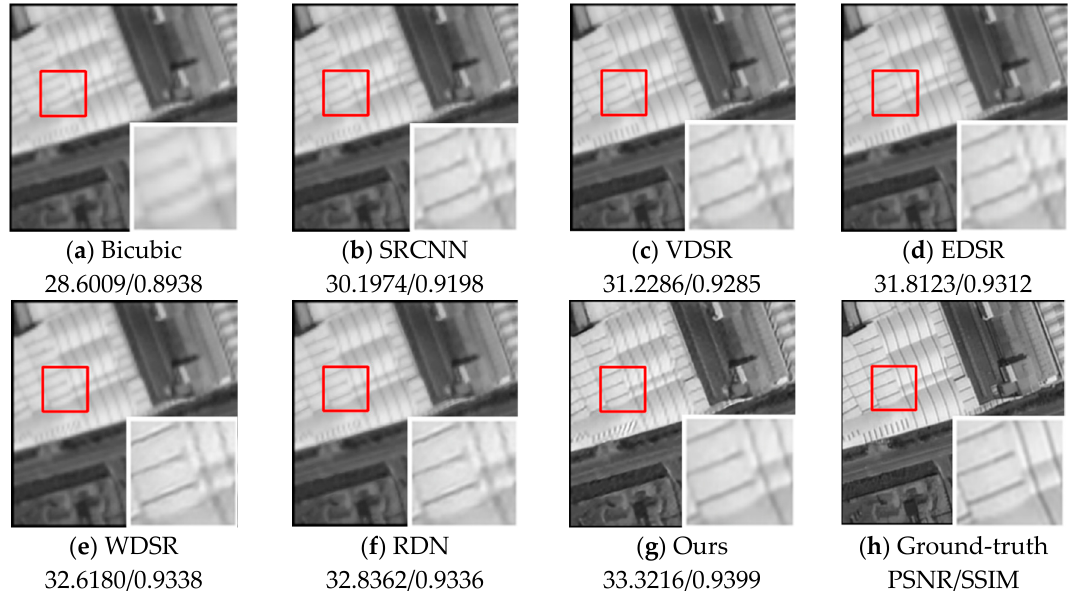
Figure 8. Qualitative comparisons of our model with other methods at the scale of ×3 on the GF-2 multispectral channels test set displayed with red, green, and blue channels.